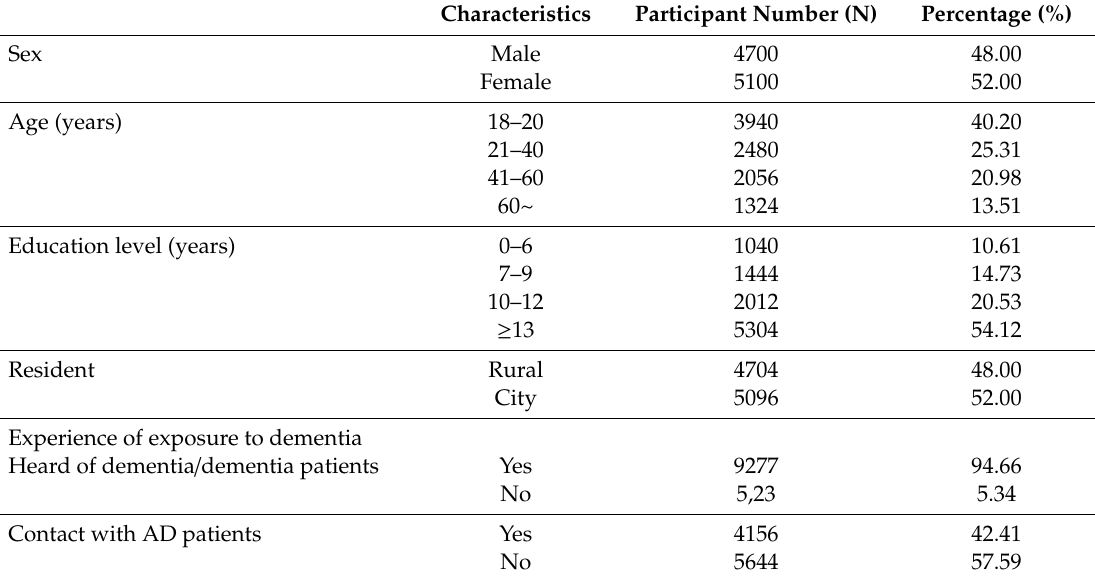
Table 1. Sociodemographic characteristics (N = 9800). AD: Alzheimer’s